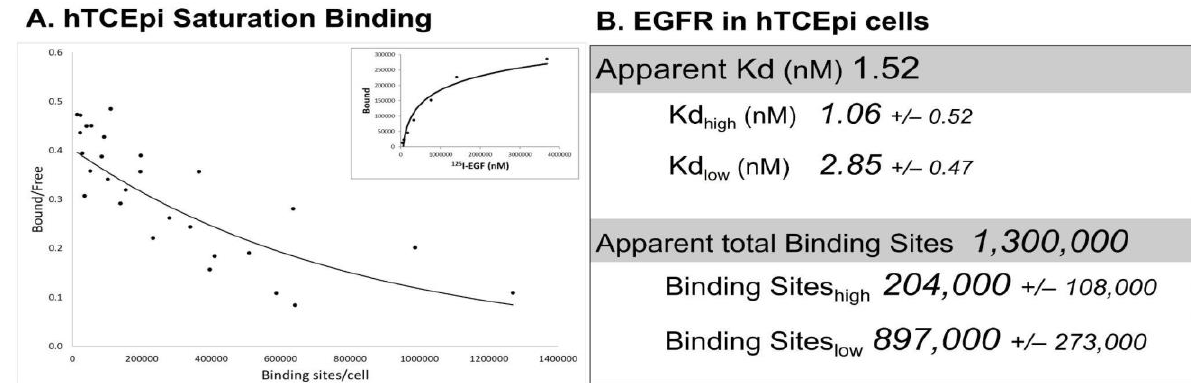
Figure 2. Saturation binding in hTCEpi cells. ( A ) Saturation binding assays were performed using adherent immortalized corneal epithelial (hTCEpi) cells [70] using 125 I-EGF (Perkin Elmer, Waltham, MA, USA), as previously described [71,72]. Shown are cummulative data from 4 independent experiments (6–7 data points/experiment) that were subjected to Scatchard transformation. The concave-up binding curve (solid line) is consistent with two affinity sites. Saturation binding from one representative experiment is shown in the inset. ( B ) The apparent Kd and total binding were generated from the summative data of all four experiments. High- and low-affinity binding sites were calculated from each experiment with PRISM utilizing a non-linear, two-site binding analysis. Data are presented as the average ± S.E.M. ( n = 4). Table 1. EGFR density in selected cell